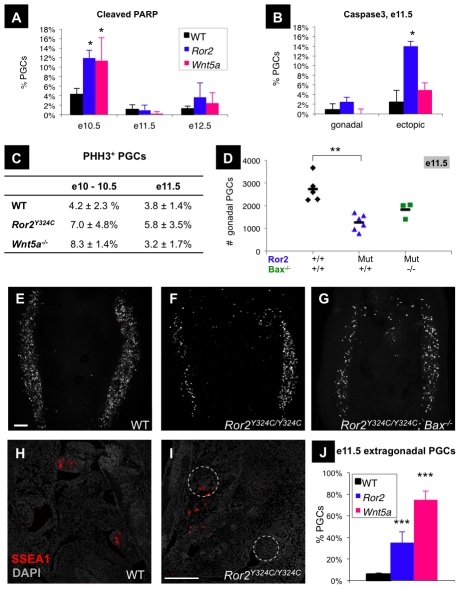
Increased PGC apoptosis and impaired colonization of the gonads in Ror2 and Wnt5a mutants.(A) The frequencies of apoptotic PGCs were similar between all genotypes in e11.5 and e12.5 gonads, but increased in Ror2 and Wnt5a migratory PGCs at e10.5 (n = 4 mutants). (B) When examined separately in e11.5 sections, the frequency of apoptotic PGCs was similar in the gonads, but increased among ectopic extragonadal Ror2 PGCs compared to WT. (C) The frequencies of PHH3+ (ectopic and non-ectopic) PGCs determined from tissue sections at e10.5 and wholemount gonads at e11.5 did not differ between WT and either mutant by t-test (mean and SD of n≥3 embryos). (D–G) The number of PGCs within Ror2Y324C e11.5 mutant gonads was not rescued to WT levels (p = 0.065) on a Bax null background, quantified in (D). GCNA staining of e11.5 wholemount gonadal ridges in stage-matched WT (E) and Ror2Y324C single mutants (F) and Bax; Ror2Y324C double mutants (G). Scale bar = 120 um. (H–J) Excess ectopic PGCs were observed in e11.5 histologic sections of Ror2Y324C (I) and Wnt5a (not shown) stained with SSEA1 and DAPI (gonads indicated by dashed circles, scale bar = 100 um). (J) The proportion of extragonadal PGCs in Ror2Y324C and Wnt5a sections (mean and SE of n = 4 slides, ∼10 sections each) was significantly increased compared to WT. Results of the Student's t-test are indicated, * p<0.05, **, p<0.01, ***p<0.001.